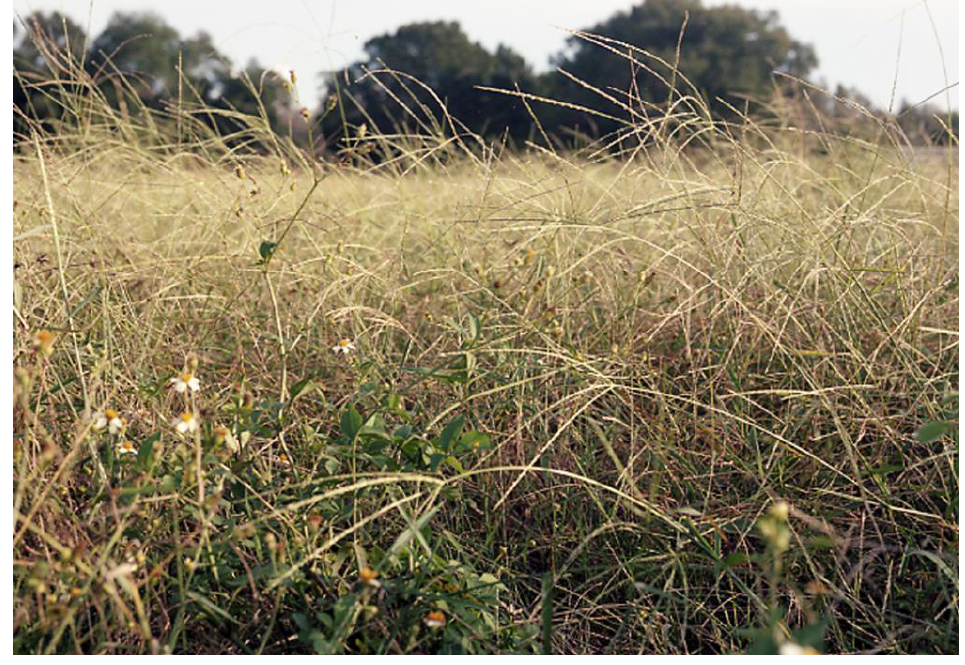
Jezabeth Roca Gonzalez, Gringolandia , 2017-2018,